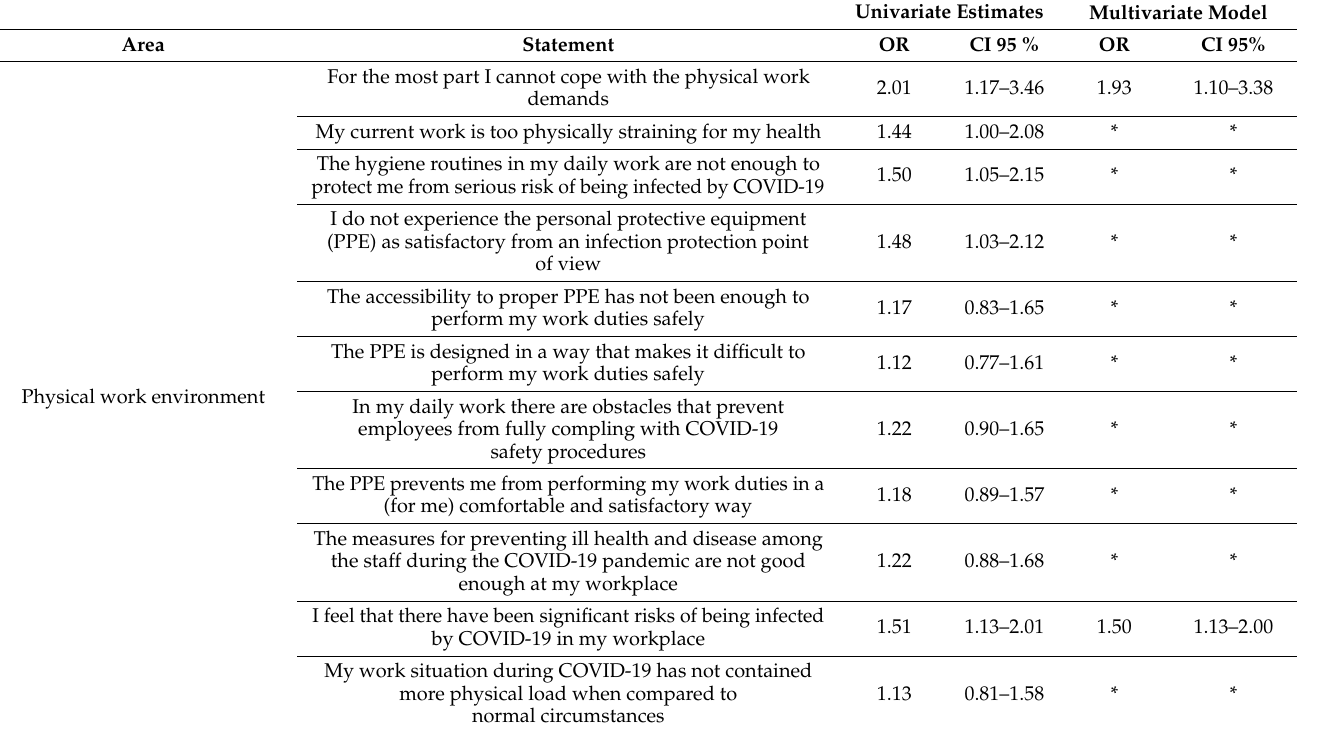
Table 4. Univariate estimates and the total multivariate model including all seven investigated areas in 2020 with COVID-19-specific questions. Statistically significant variables in relation to work-related mental health diagnoses in 2020. OR = Odds ratio; CI = Confidence interval. Nagelkerke R square 0.115. * The variable shows no statistical significance in the multivariate modelling and is, therefore, not included in the final multivariate model shown in this